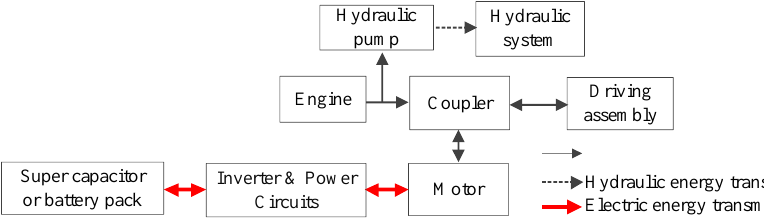
Figure 7. Typical configuration of parallel oil–electric hybrid system [40–43].